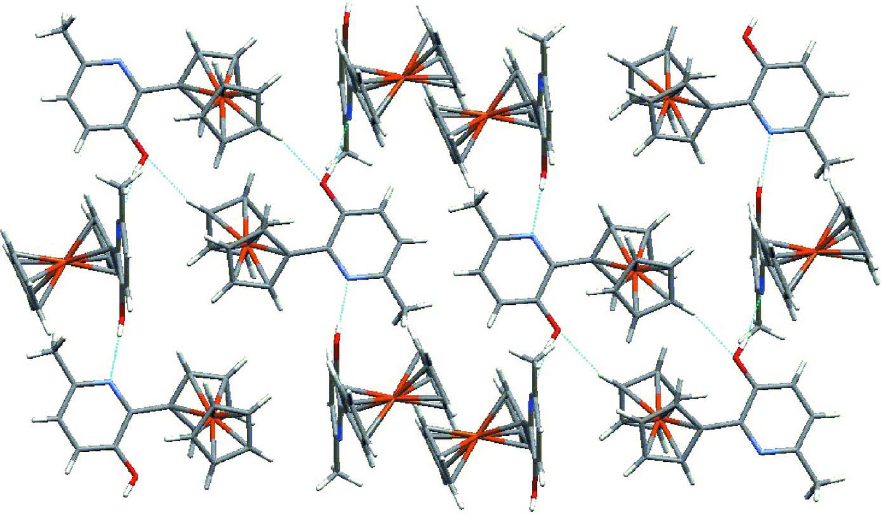
Figure 2 Partial view of the crystal packing showing the intermolecular O—H···N and C—H···O hydrogen bonds. One disordered component of the methyl group has been omitted for